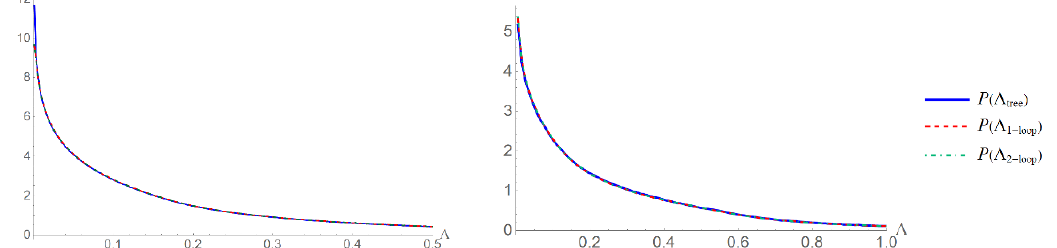
Figure 4 . Probability distribution P ((cid:3)) for the (cid:30) 3 model (left) with c randomized in [0 ; 1]; and for the (cid:30) 4 model given in eq. (2.2) and eq. (2.16) (right). In each case, the blue solid curve is for the tree-level P ((cid:3) 0 ), the red dashed curve is for the one-loop corrected P ((cid:3) 1 ) and the green dot-dash curve is for the two-loop corrected P ((cid:3) 2 ). In each case, the loop-corrected and the tree P ((cid:3))s are essentially on top of each other, showing that loop corrections have little impact on the distribution P ((cid:3)). In particular, the peaking behavior of P ((cid:3)) at (cid:3) = 0 remains intact. Going back to the (cid:30) 3 model with c = 1, we (cid:12)nd that the loop corrected P ((cid:3) 1 ) and P ((cid:3) 2 ) are very close to the tree P ((cid:3) 0 ) shown in (cid:12)gure 2. Figure 3 shows the ratio of the